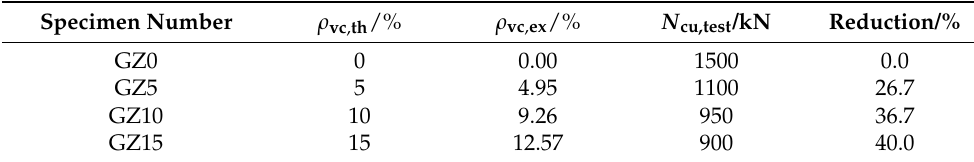
Table 4. Test results for ultimate bearing capacity.